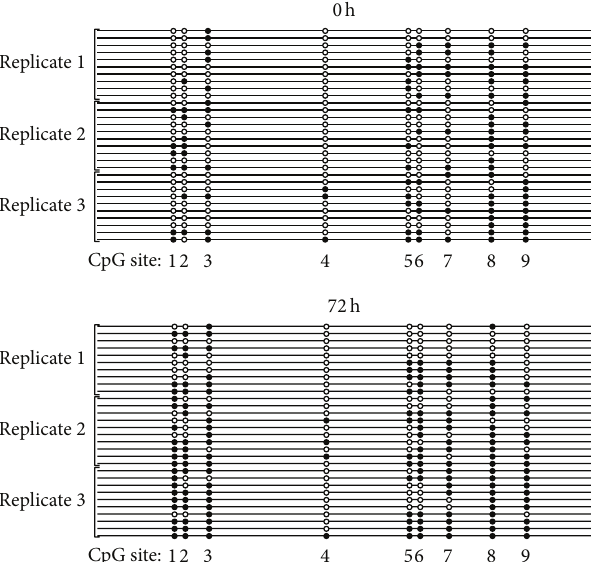
Figure 5: CpG methylation in individual copies of the CRH prox- imal promoter. Three replicate sets of BeWo cells were processed for clonal bisulfite sequencing at the 0 h (upper panel) and 72 h (lower panel) treatment times. Ten randomly selected clones were sequenced from each culture. Each line represents one copy of the promoter with open and closed circles denoting unmethylated and methylated CpGs, respectively. CpG site numbers as shown in Figure 3 are also